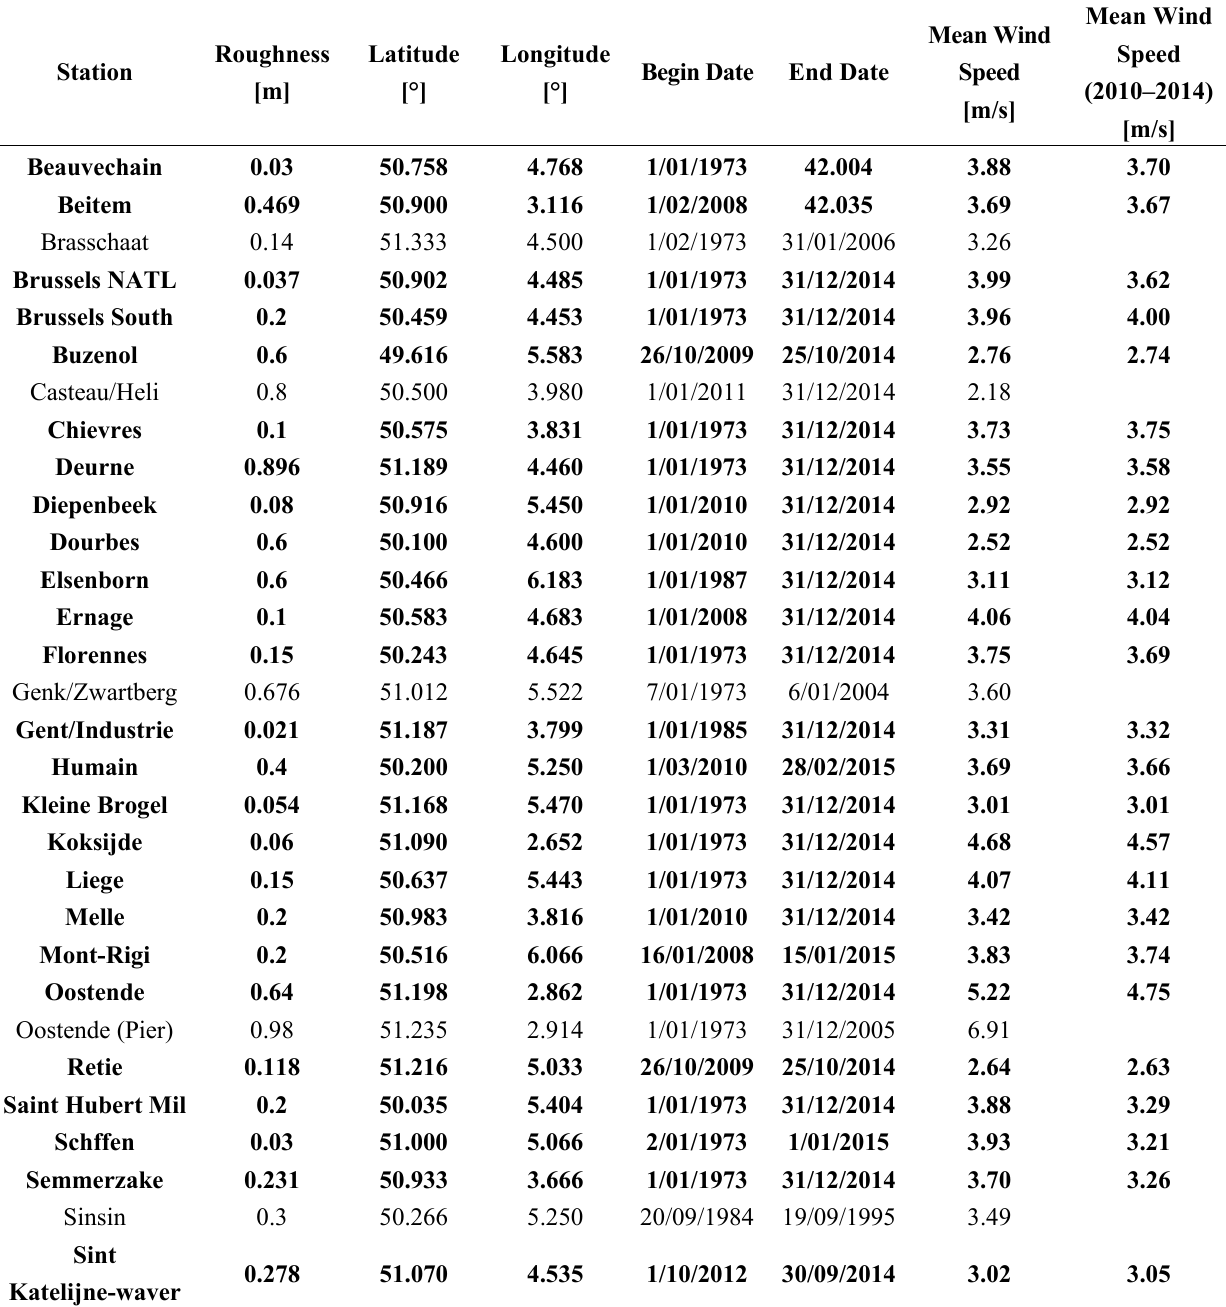
Table 1. Summary of the measurement stations (height 10 m). The recent data is (2010–2014) indicated in bold letter type